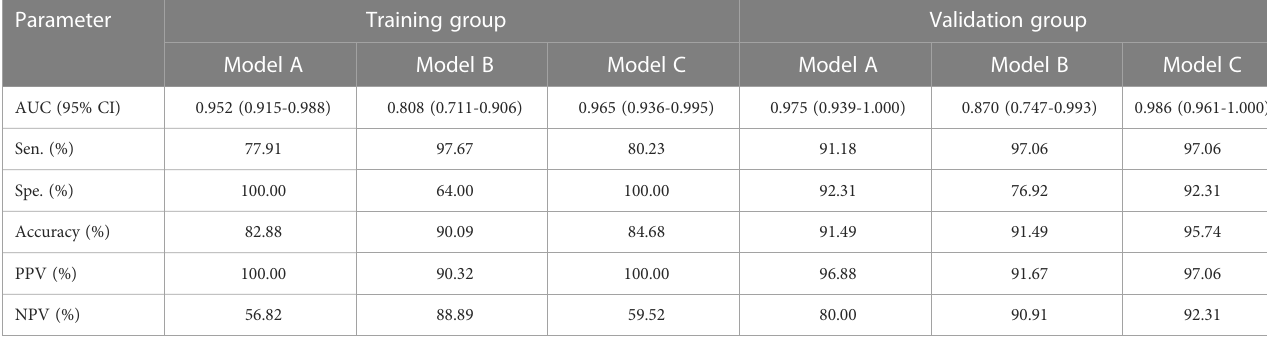
TABLE 4 Performance of the prediction model in the diagnosis of benign and malignant breast lesions in the training and validation